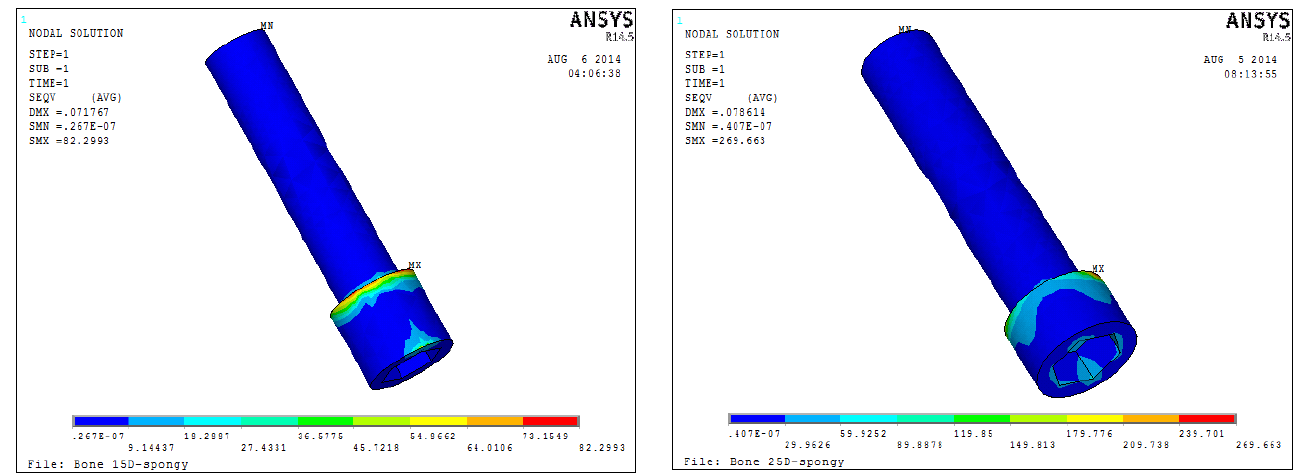
Fig. 6: Screw Von Mises stress distribution comparison between (a) 15°, (b) 25° angulated abutment under Zirconia crown.